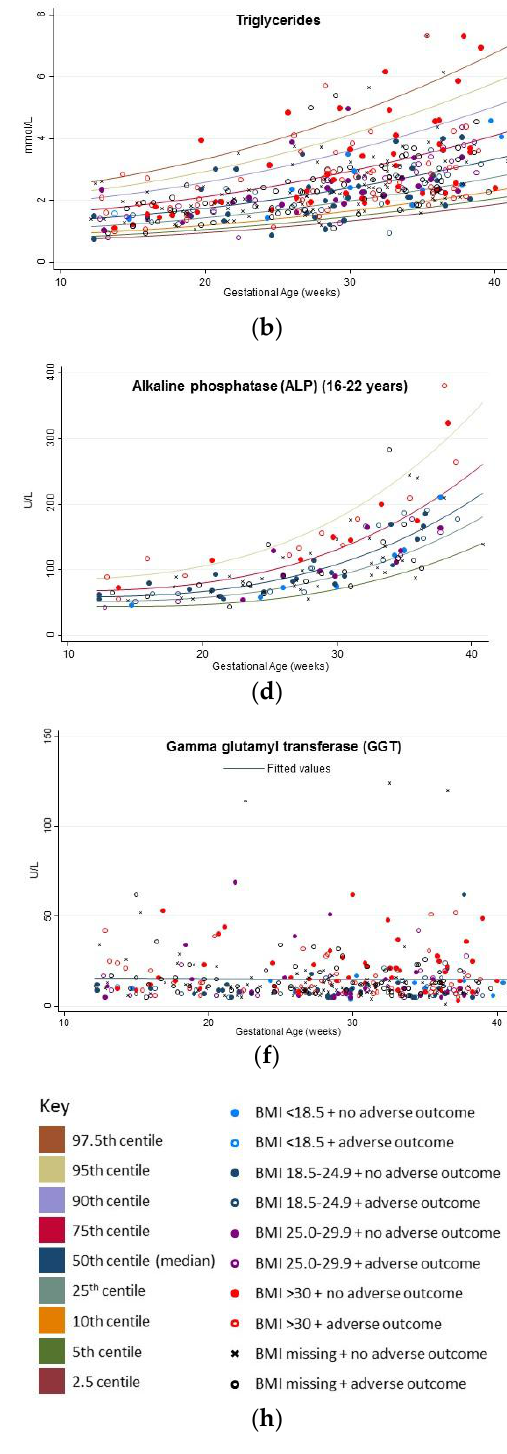
Figure 1. Non-fasting percentile ranges: ( a ) Cholesterol ( n = 398 observations); ( b ) triglycerides ( n = 397 observations); ( c ) Cystatin C ( n = 348 observations); ( d ) ALP (16 years to less than 22 years) ( n = 132); ( e ) ALP (22 years and older) ( n = 263 observations); ( f ) GGT ( n = 397 observations); ( g ) hs-CRP ( n = 382 observations). ( h ) Key designating colors and symbols for centile bands, BMI categories and status of adverse outcomes related to pregnancy. Adverse outcomes related to pregnancy include gestational hypertension, preeclampsia, gestational diabetes, proteinuria, albuminuria, large for gestational age and small for gestational age babies.